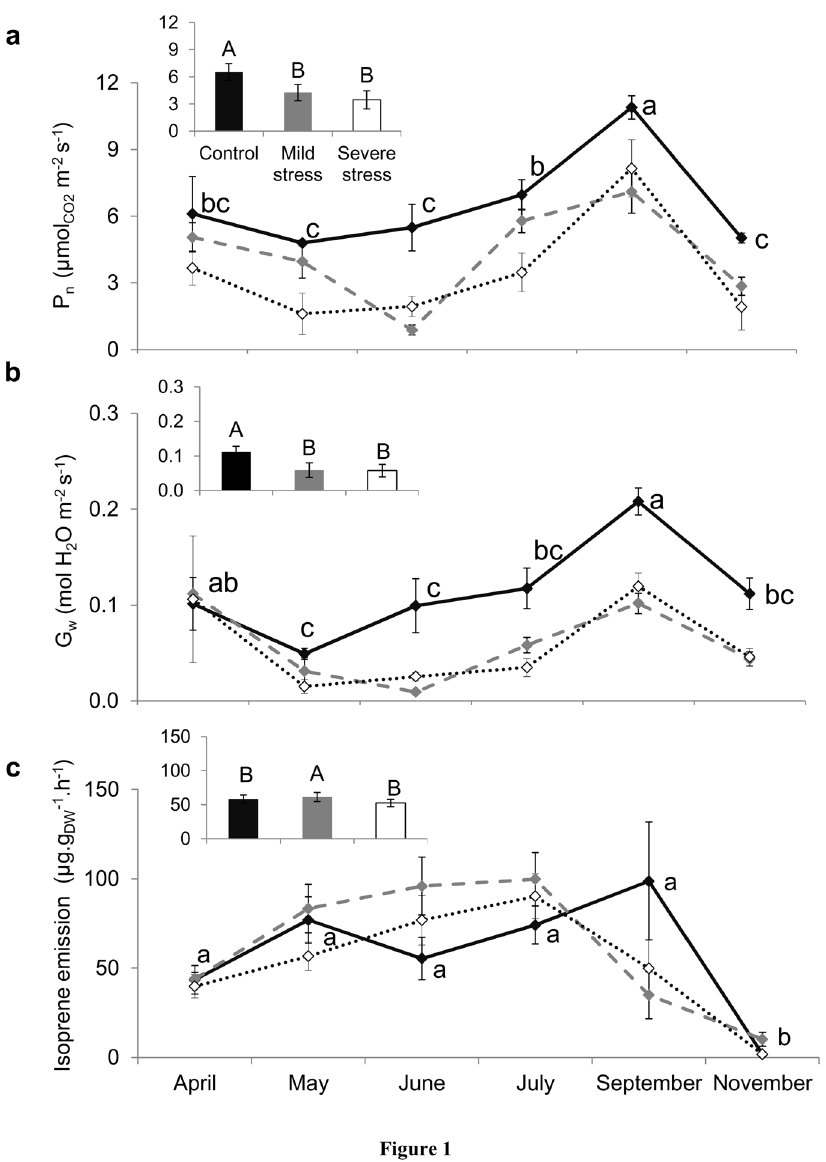
Figure 1. Gas exchanges (photosynthesis, stomatal conductance and isoprene). Seasonal course of the net photosynthesis (P n , graph a), stomatal conductance to water vapor (G w , graph b) and isoprene emissions (graph c) under control (– X –), mild ( ) and severe ( ??? e ??? ) water stressed. Note that 70% of isoprene emissions were mostly measured under standard conditions (refer to materials and method for details). Differences are tested using a two-way ANOVA repeated measures (F) followed by Tukey tests. Since interaction between seasonality and treatment is not significant according to the two-way ANOVA, results of water stress impact are shown in the small graph where data of all months are pooled together and differences between treatments are denoted by capital letters (A . B) while seasonality impact is shown in the main graph (in lower case letters: a . b . c). Values are mean 6 SE of n=5. status was estimated through two parameters: midday stem water potential ( y mid ) - measured using a pressure chamber (PMS instrument, Co. Oregon USA) - and leaf relative water content (LRWC) calculated following the formula: LRWC = (FM-DM)/ (SM-DM) where FM is fresh mass, DM is dry mass and SM is saturated mass. Leaf dry mass was measured by weighing the leaves after they had reached constant mass in an oven at 70 u C. Leaf mass to area ratio (LMA), an indicator of leaf sclerophylly [30], was calculated by dividing leaf dry mass by leaf area, which was calculated using a leaf area meter (AM300 Bioscientific).